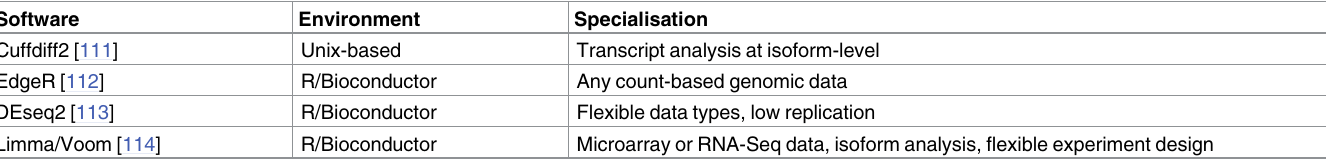
Table 4. RNA-Seq differential gene expression